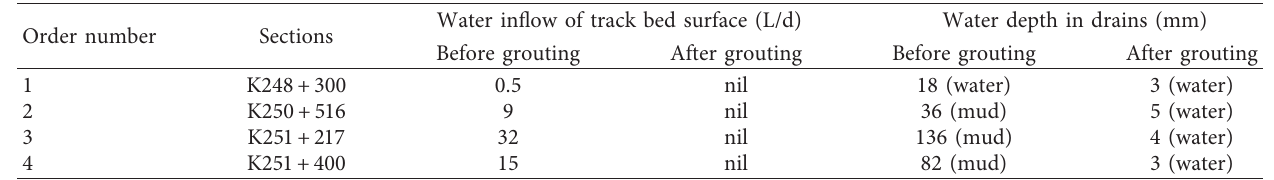
Table 11: Tunnel leakage before and after grouting.